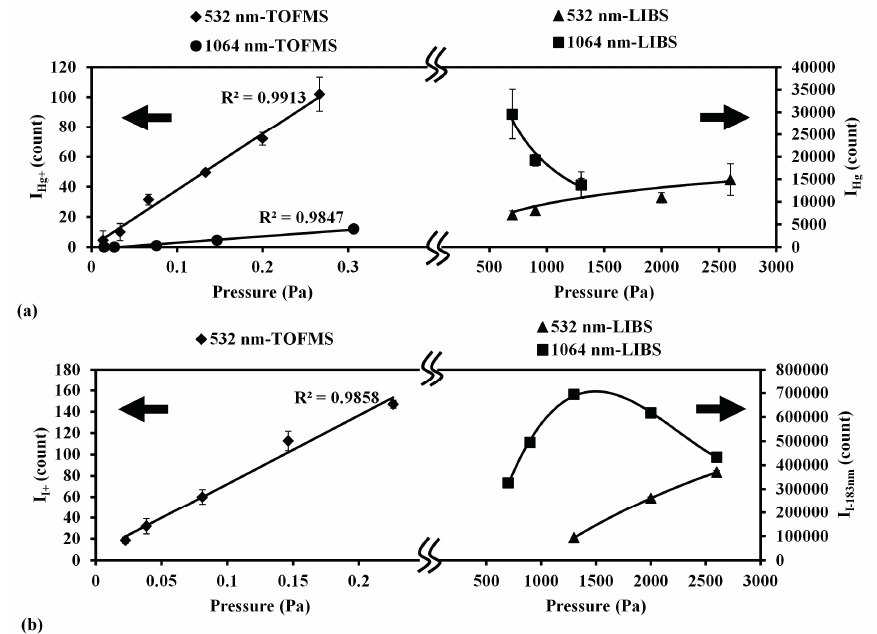
Figure 8. Pressure dependence of ion and emission signal intensities using 532 nm and 1064 nm laser irradiation in the LB-TOFMS and LIBS systems. ( a ) Mercury ion and emission signal intensities. Conditions: LB-TOFMS, ns 1064 nm laser irradiation, buffer gas N 2 , power 838 mJ/p, mercury concentration 8.3 ppm, lens angle α 0°. ns 532 nm laser irradiation, buffer gas N 2 , power 100 mJ/p, mercury concentration 0.86 ppm, lens angle α 10°. LIBS, ns 532 nm and 1064 nm laser irradiation, delay time 1060 ns, power 400 mJ/p, beam diameter 9 mm, gate width 30 μ s; ( b ) Iodine ion and emission signal intensities. Conditions: LB-TOFMS, ns 532 nm laser irradiation, buffer gas N 2 , power 40 mJ/p, iodine concentration 5.05 ppm, lens angle α 10°. LIBS, ns 532 nm and 1064 nm laser irradiation, delay time 1060 ns, power 400 mJ/p, beam diameter 9 mm, gate width 30 μ